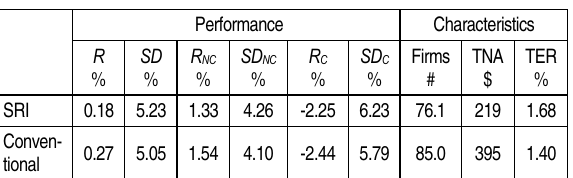
Table 1 . Summary